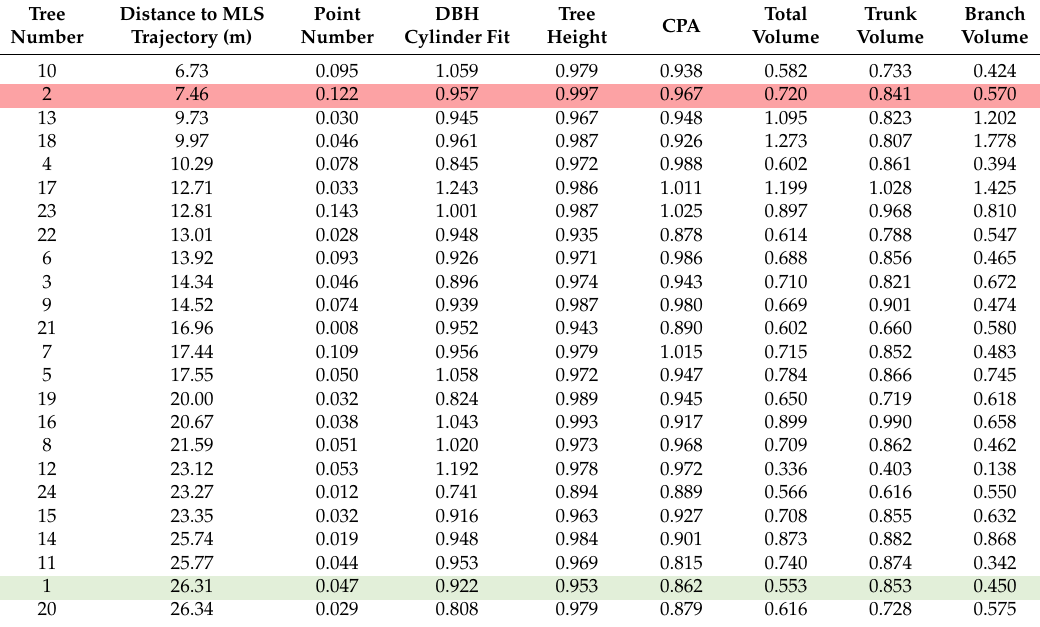
Table A3. Proportion x MLS /x TLS of the parameters derived from the QSM of 24 trees of plot 1 determined with TLS and MLS in ascending order with the distance to the trajectory. The two trees from Figure 9 are marked with a green ( Carpinus betulus ) and red ( Fagus sylvatica ) color.